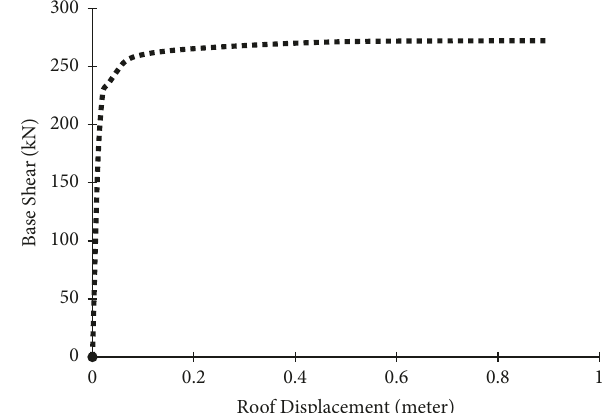
Figure 18: TS-BRB portal frame pushover